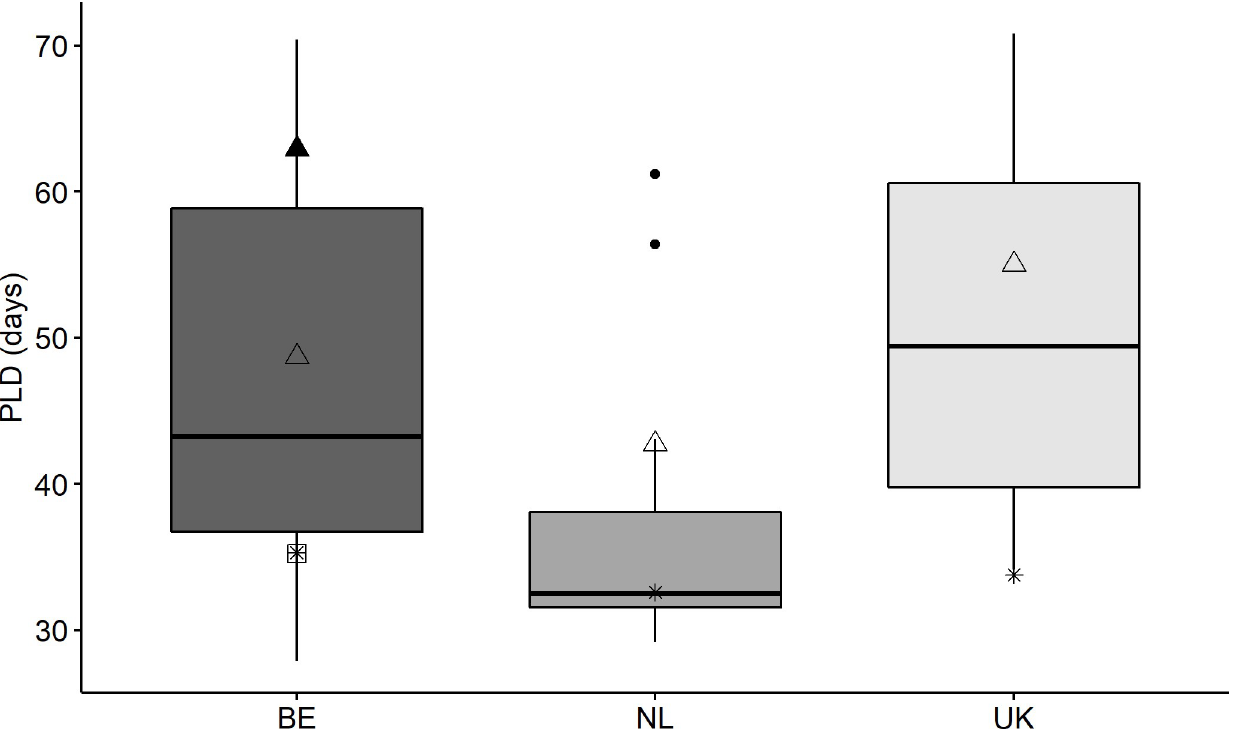
Fig 4. Boxplot of PLD excluded of the yolk sac larval phase predicted for Belgium (BE), the Netherlands (NL) and the United Kingdom (UK) for the period 1995 to 2015. Triangles highlight the mean values predicted for the years of 2013 ( ▲ ) and 2014 ( 4 ) in Belgium, 2014 in the Netherlands ( 4 ) and 2015 in the UK ( 4 ). The observed values are indicated as a square ( □ ) for the year of 2013 in Belgium and asterisks ( � ) for the year of 2014 in Belgium, 2014 in the Netherlands and 2015 in the UK.